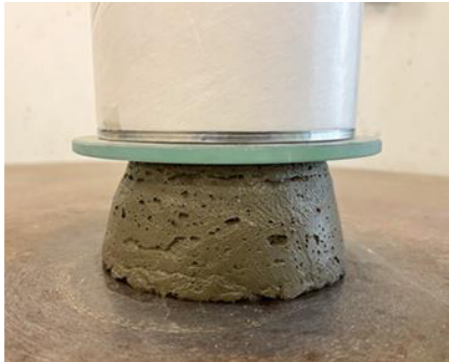
Figure 2. The modified minislump shape-retention ability test.